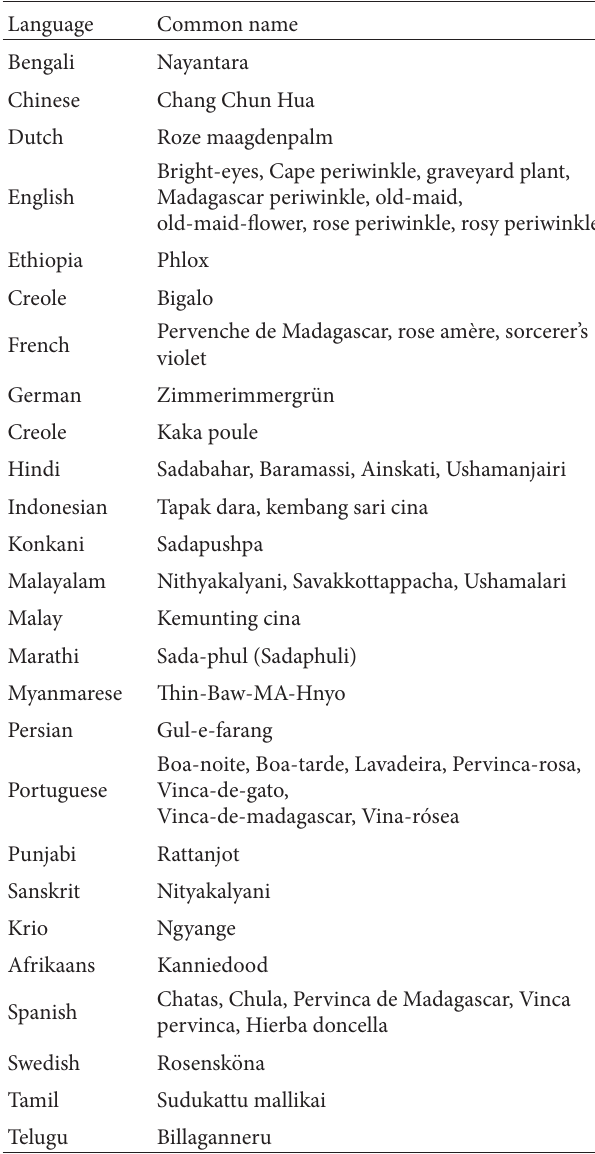
Table1:VernacularnamesofMadagascarperiwinkle( Catharanthus roseus ) in different languages ∗